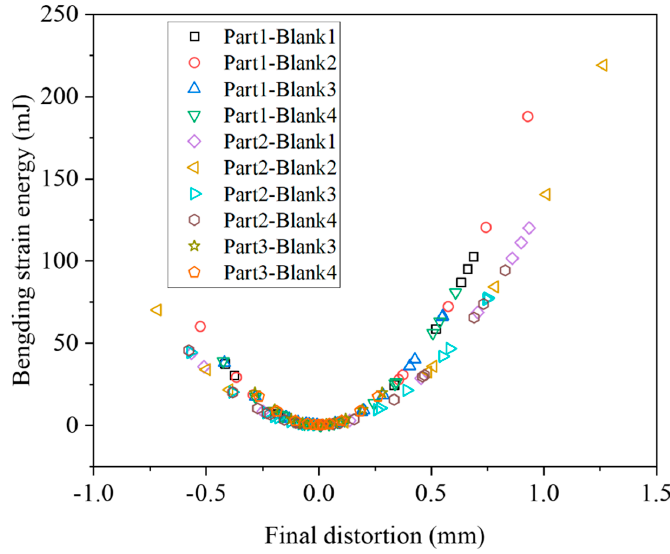
Figure 10. The bending energy vs. final part distortion.